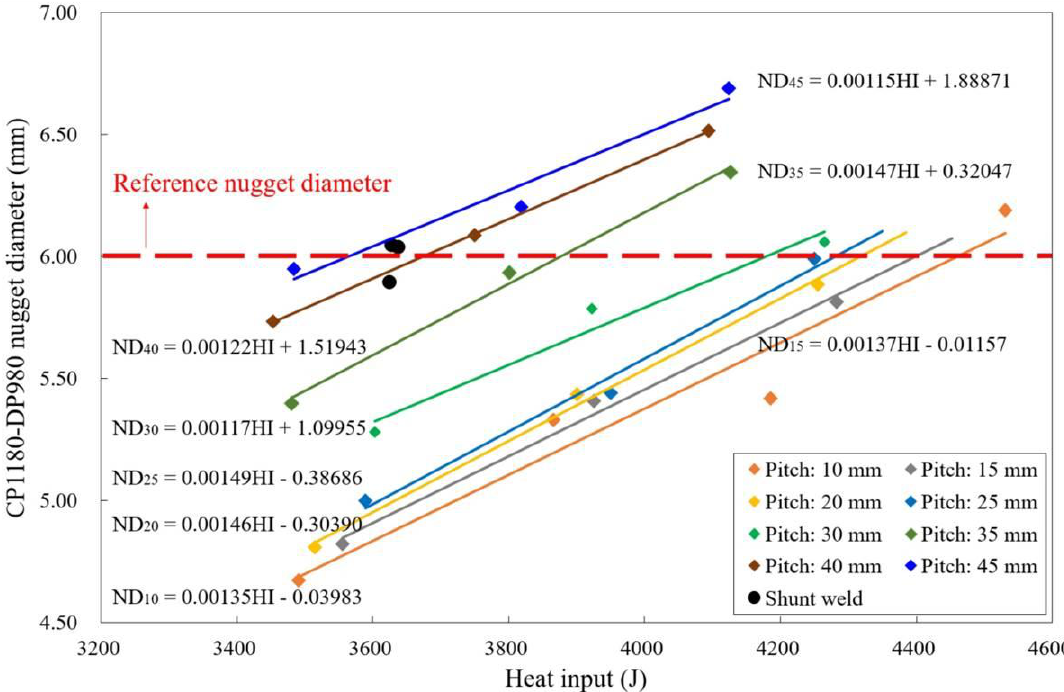
Figure 12. CP1180-DP980 nugget diameter as a function of the heat input for various weld pitches.